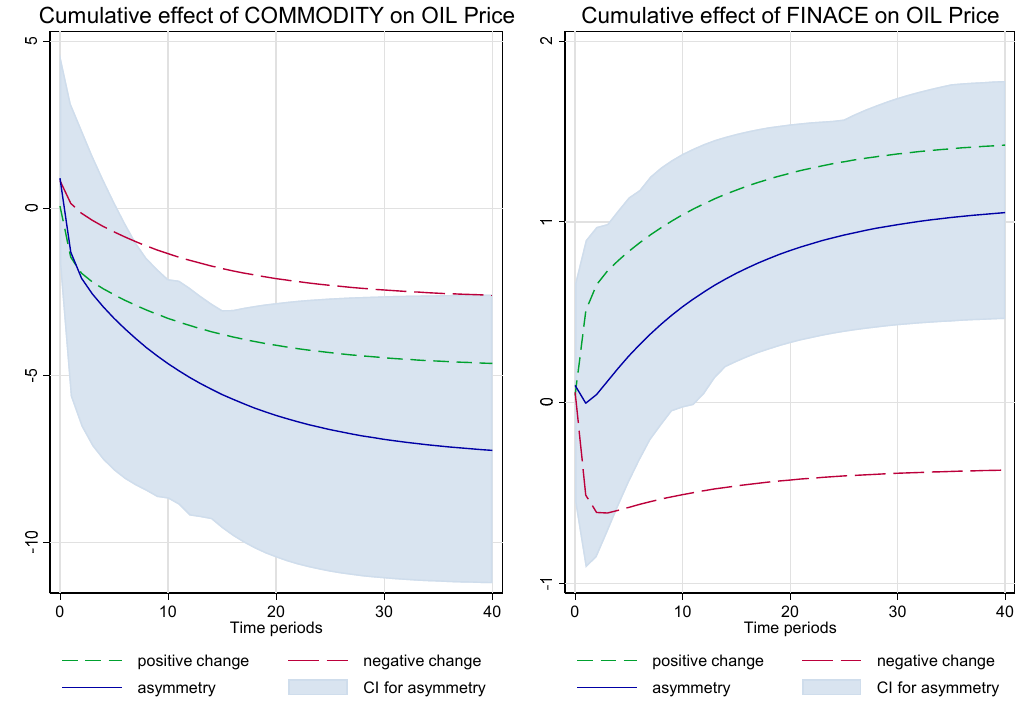
Figure 4. The asymmetric effects of crude oil attributes in 2008–2014. Notes: The number of bootstrap replications for asymmetry plot is 100, confidence level (CI) for asymmetry is in 95%.